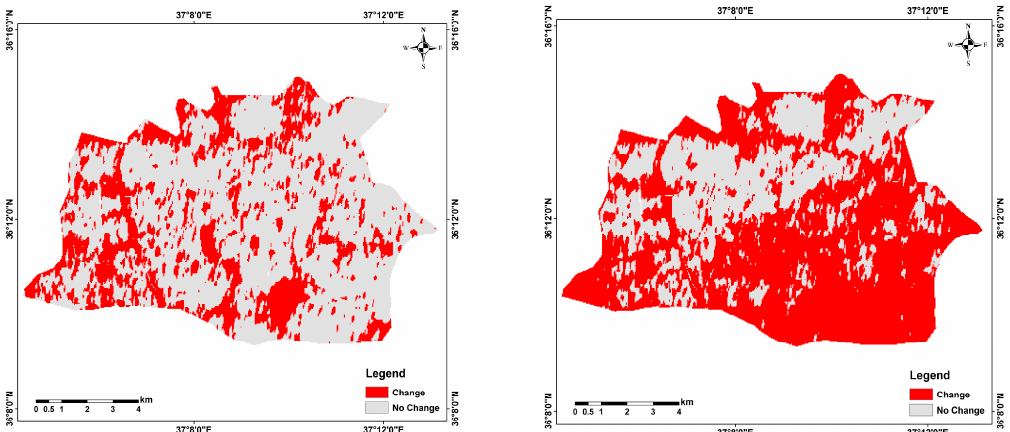
Figure 6. Aleppo Coherence image classified into change and no change showing images before and after the Syrian Government operation. Images before conflict intensification (4 July 2016, left ) and after conflict intensification (30 April 2017, right ).